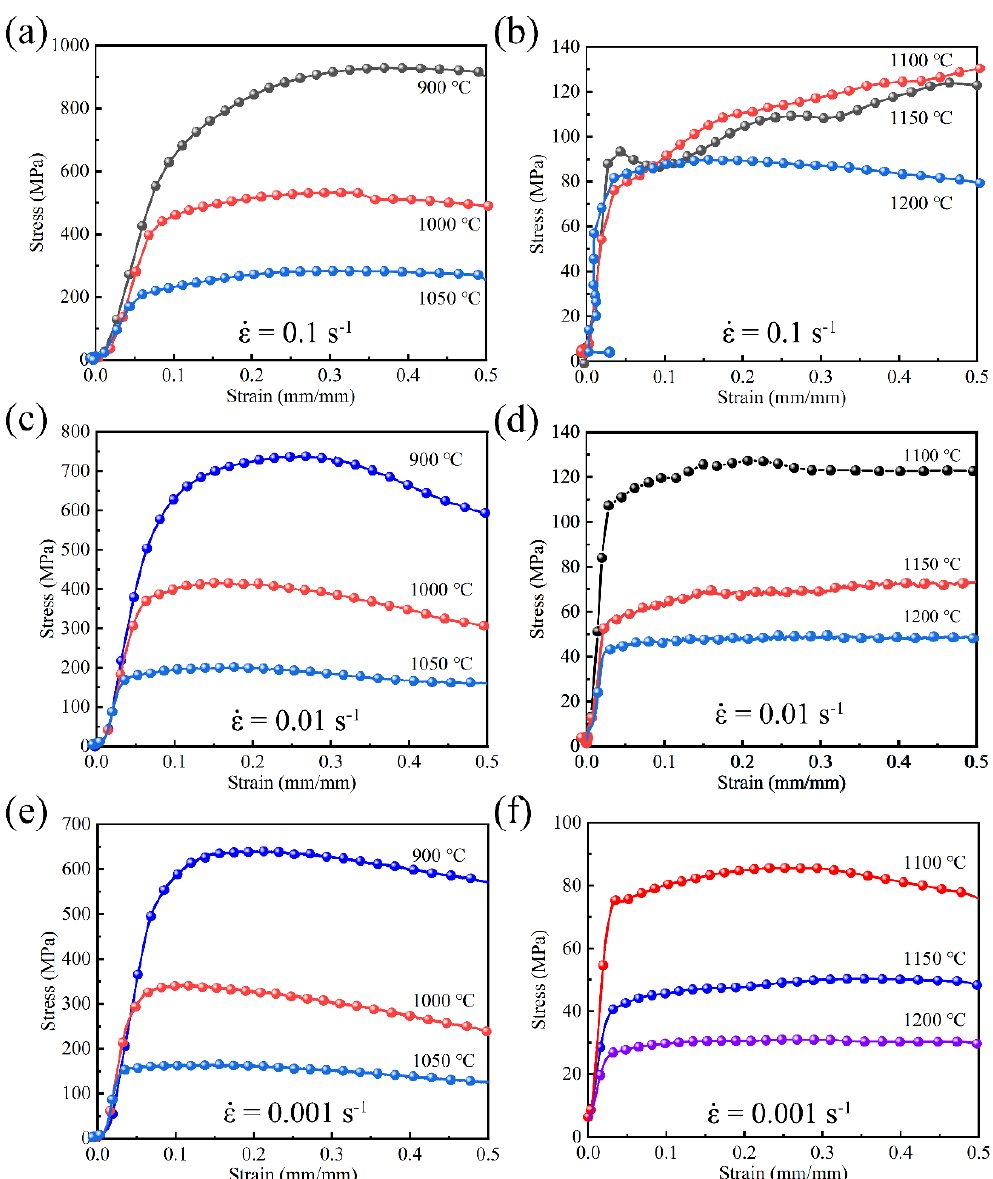
− 1 ; ( c , d ) at 0.01 s − 1 ; ( e , f ) at 0.001 s − 1